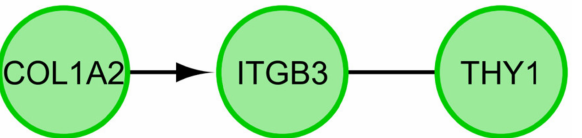
Figure 7. Functional interaction (FI) between 10 most upregulated and 10 most downregulated genes that belongs to the “cell differentiation”, “cell growth”, “cell maturation” and “cell development” GO BP terms as well as “signaling pathways regulating pluripotency of stem cells” KEGG pathway. In